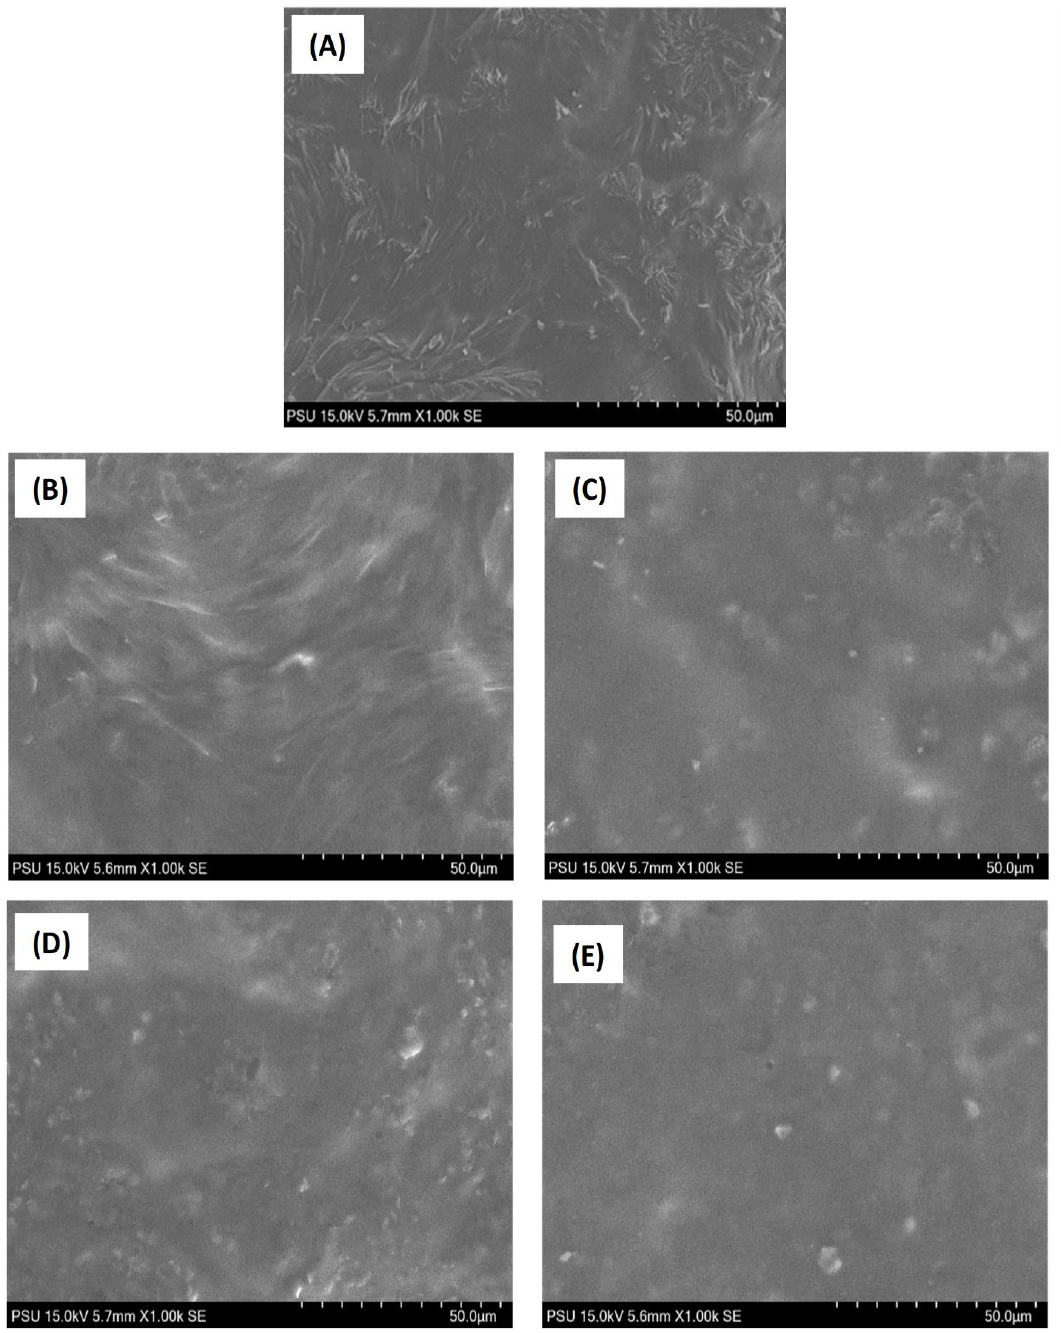
Figure 6. Microstructural observation of the surface section ( A – E ) of chitosan–NGRS based edible film incorporated with and without EOs. ( A ) represents control film; ( B ) represents garlic oil added film; ( C ) represents galangal oil added film; ( D ) represents turmeric oil added film; ( E ) represents kaffir lime oil added film.